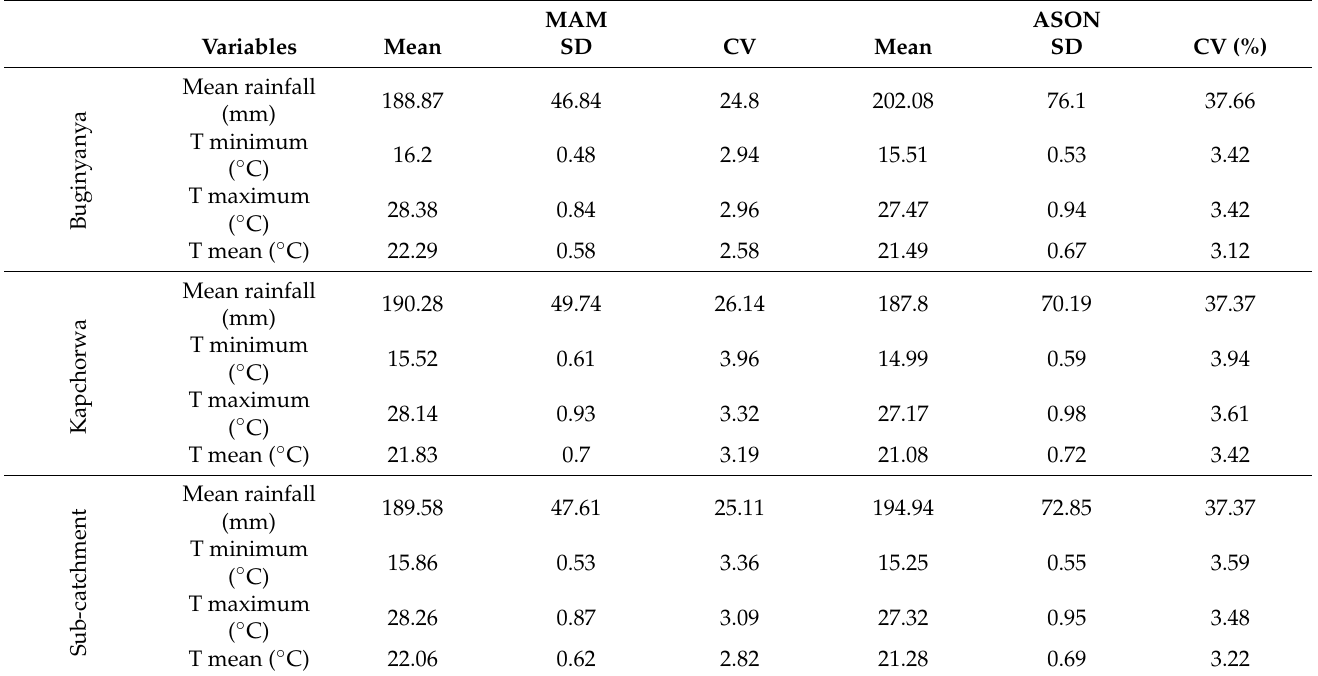
Table 3. Seasonal variabilities of rainfall and minimum, maximum, and mean temperature (1981–2015). MAM